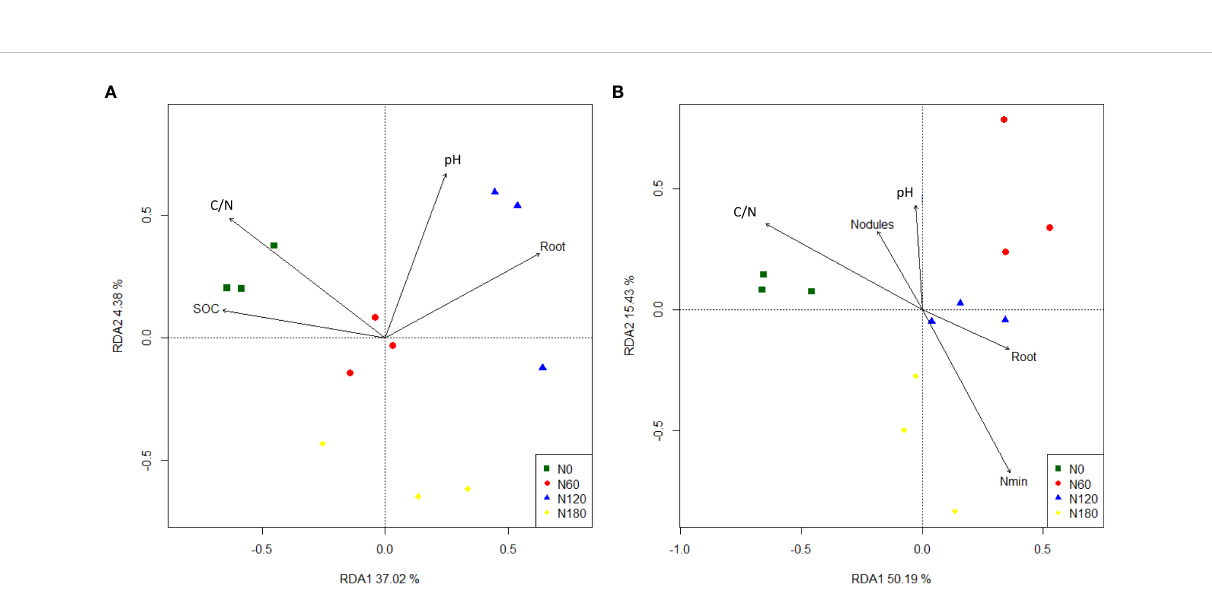
FIGURE 4 Ordination plots of the redundancy analysis (RDA) to identify relationships between bacterial (A) and fungal (B) OTUs and environmental variables. SOC, soil organic carbon; DOC, dissolved organic carbon; N min , soil mineral nitrogen; C/N, soil carbon: nitrogen ratio; Root: root biomass; Nodules: the fresh weight of